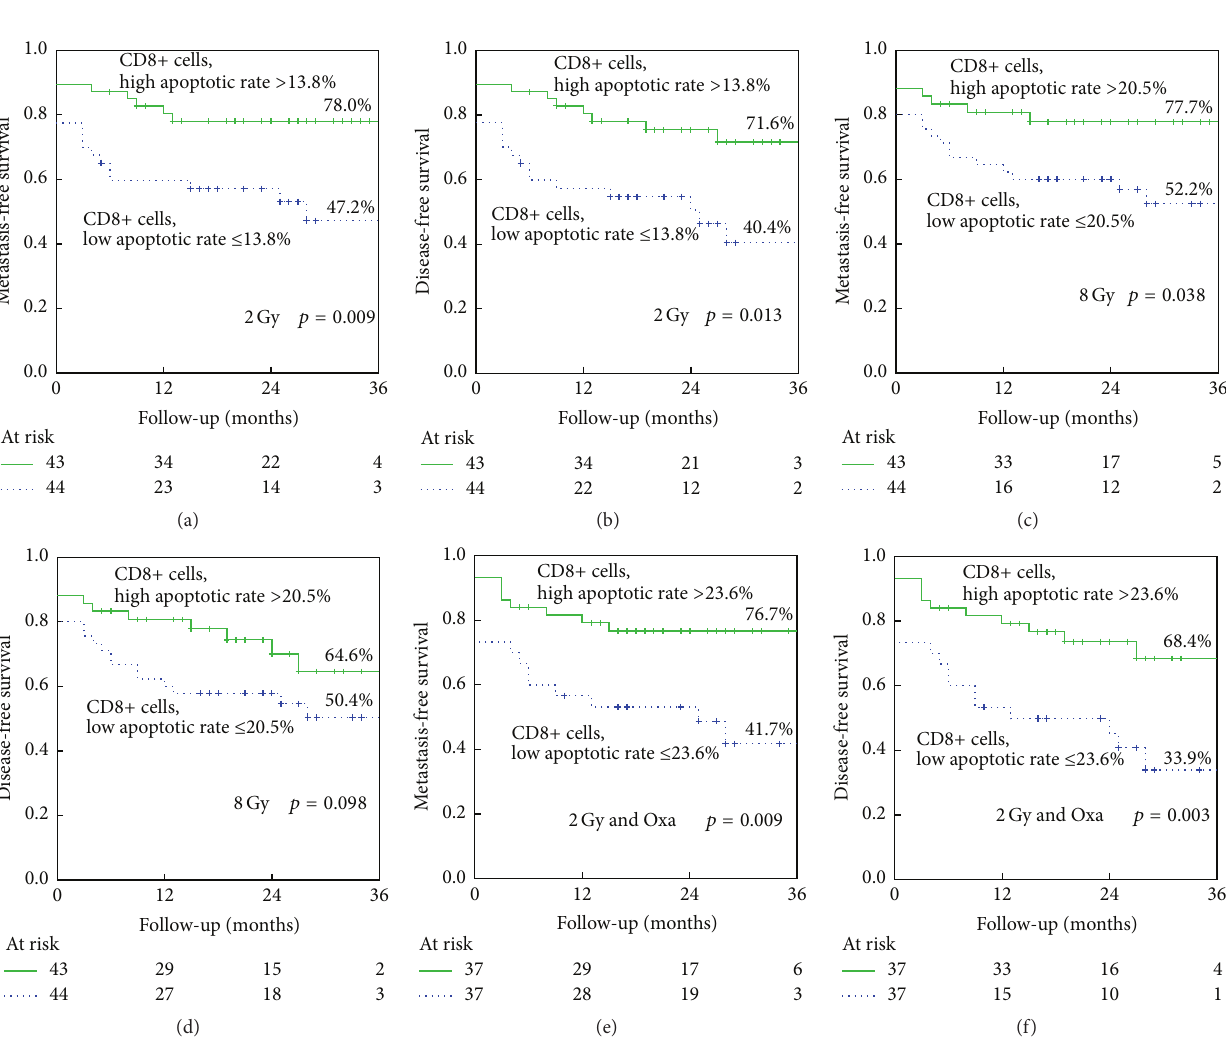
Figure 3: Kaplan-Meier analysis of CD8+ apoptotic rates after 2 Gy (a) metastasis-free survival, (b) disease-free survival, 8Gy, (c) metastasis- free survival, (d) disease-free survival and 2 Gy and 10 𝜇 g/mL Oxaliplatin, (e) metastasis-free survival, and (f) disease-free survival. 𝑝 values arecalculated by thelog-ranktest. Numbersof patientsat riskat thetimesof0, 12,24, and 36 monthsoffollow-up and percentage ofremaining patients with event-free survival are